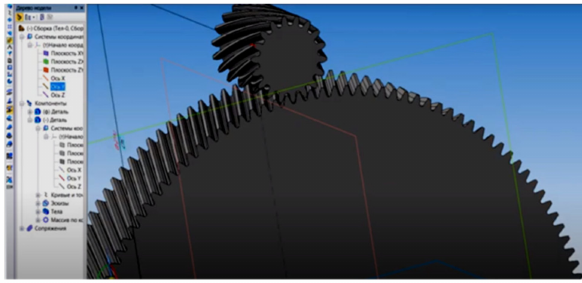
Figure 7. Element-wise modeling of a pair of